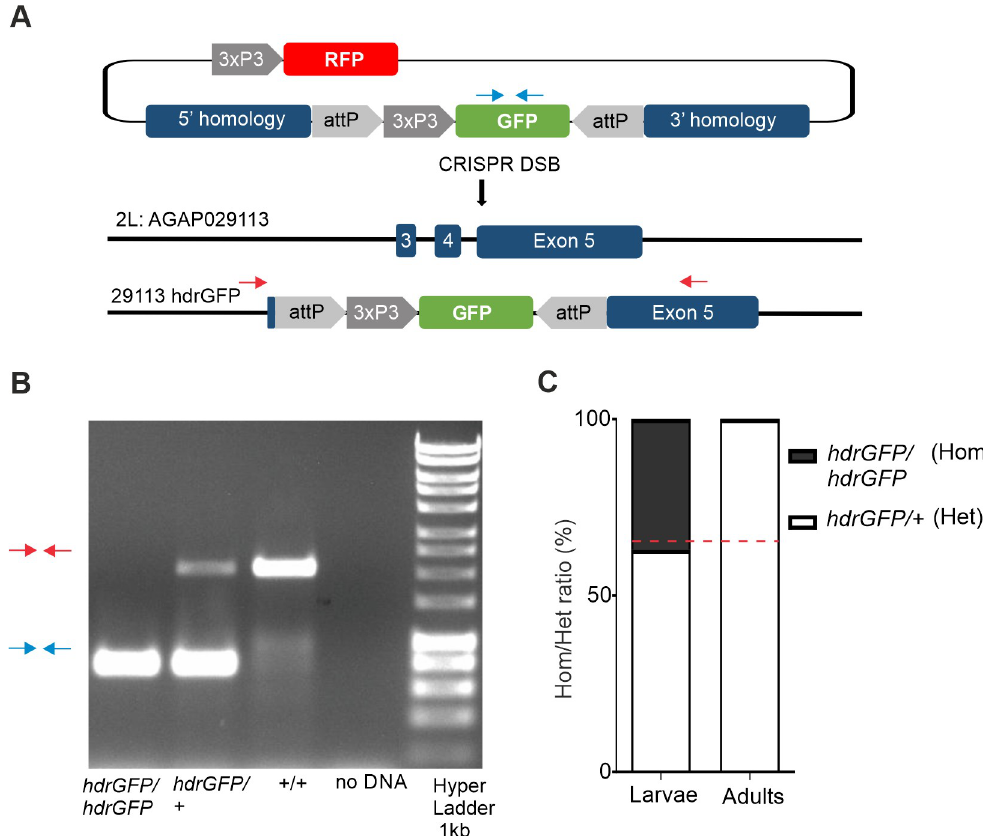
Fig 1. Gene disruption by HDR at a conserved site in exon 5 of AGAP029113 causes recessive lethality. (A) Schematic representation of disruption of the AGAP029113 gene. (B) PCR was used to confirm the targeted loci in WT individuals (red arrows) as well as those homozygous and heterozygous for the 29113 hdrGFP allele (blue arrow). (C) Heterozygous females and males were crossed with each other and the offspring was selected for GFP expression. Displayed is the percentage of homozygous (29113 hdrGFP/hdrGFP ) and heterozygous (29113 hdrGFP/+) L1 larvae (N = 60) and adults (N = 60) analysed by PCR as well as the expected homozygote vs heterozygote ratio according to Mendelian inheritance (red dashed line).